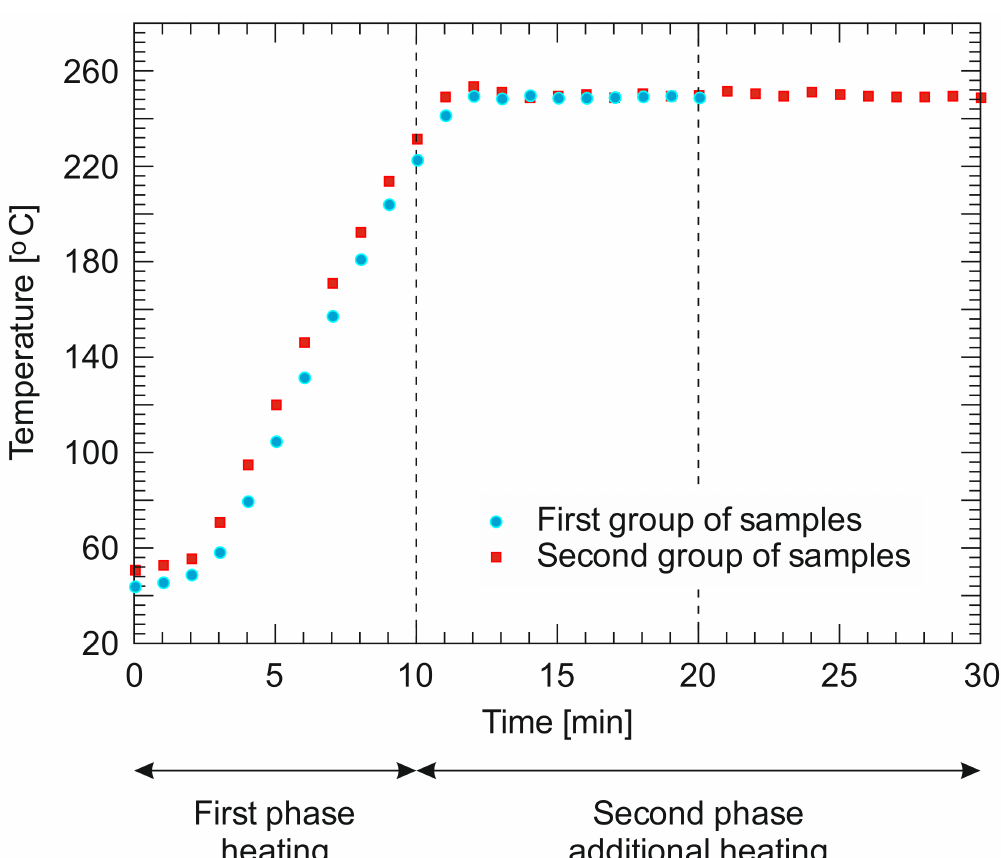
Figure 2. Temperature–time measured with the thermocouples mounted on the surfaces of the